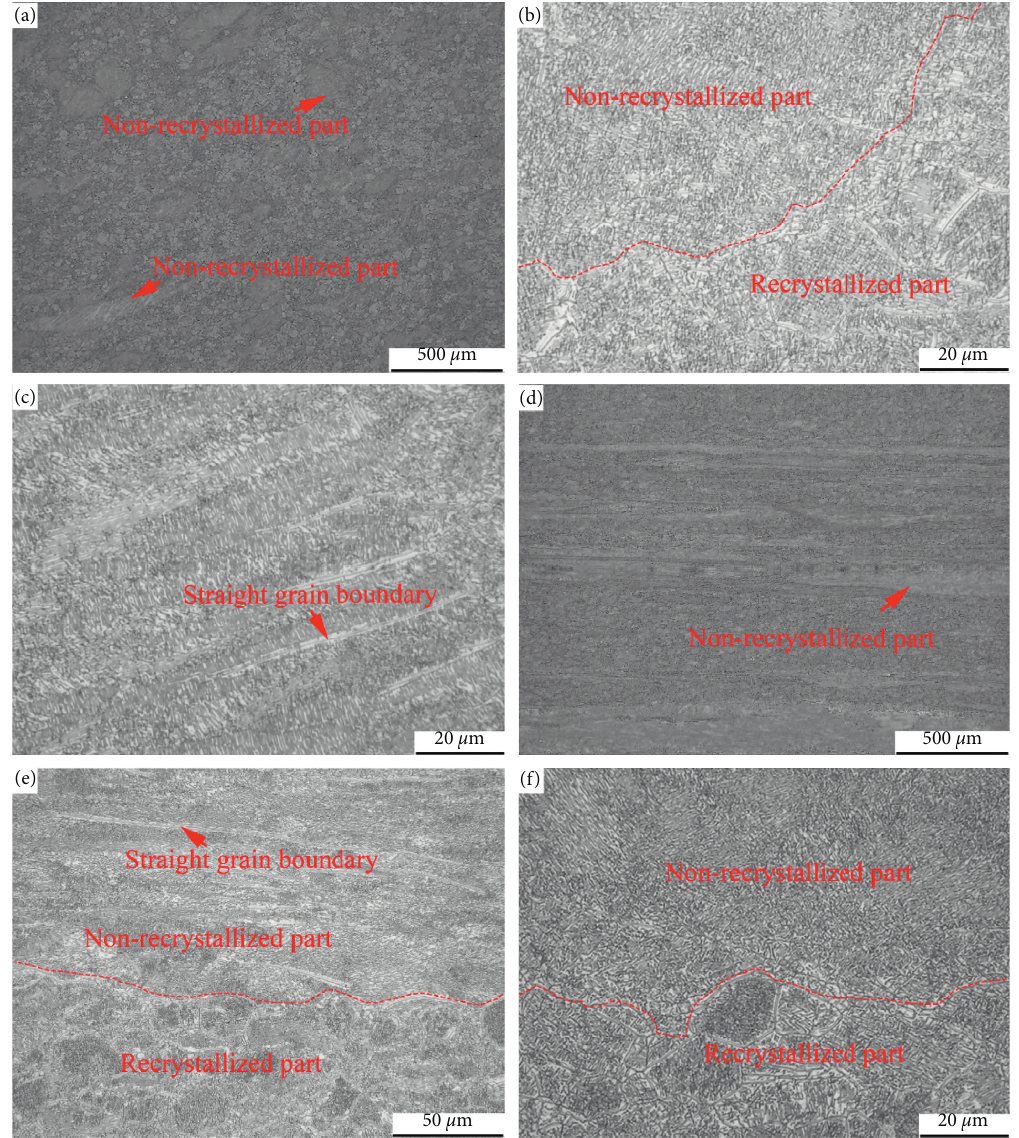
Figure 1: Micrographs of as-received materials: (a)-(c) at transverse sections; (d)-(f) at longitudinal sections.